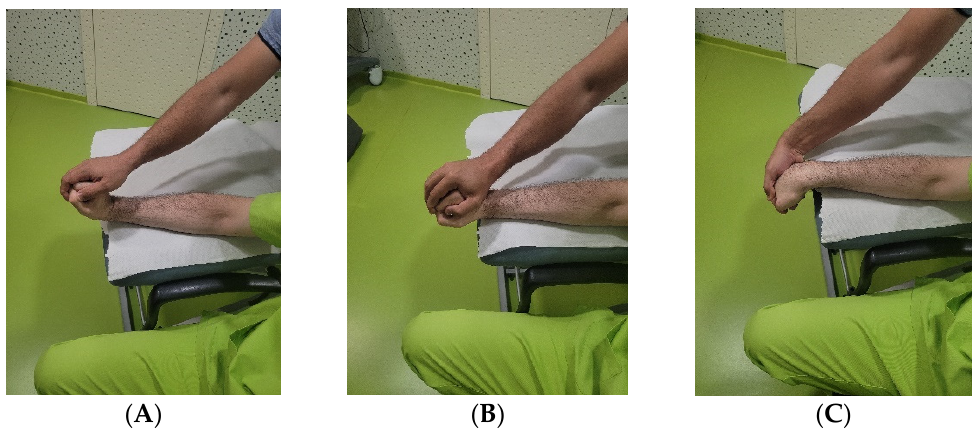
Figure 2. Patient performing the exercises in the intervention group. ( A ): Starting position. ( B ): Intermediate position. ( C ): Final position.